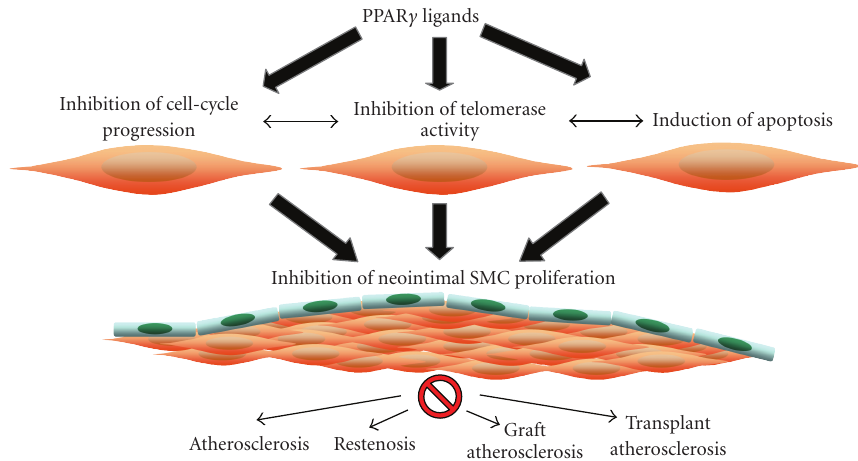
Figure 1: Cellular mechanisms involved in the inhibition of SMC proliferation by PPAR γ during cardiovascular diseases. PPAR γ regulates genes encoding proteins involved in diverse SMC processes including cell proliferation, cell-cycle progression, senescence, and